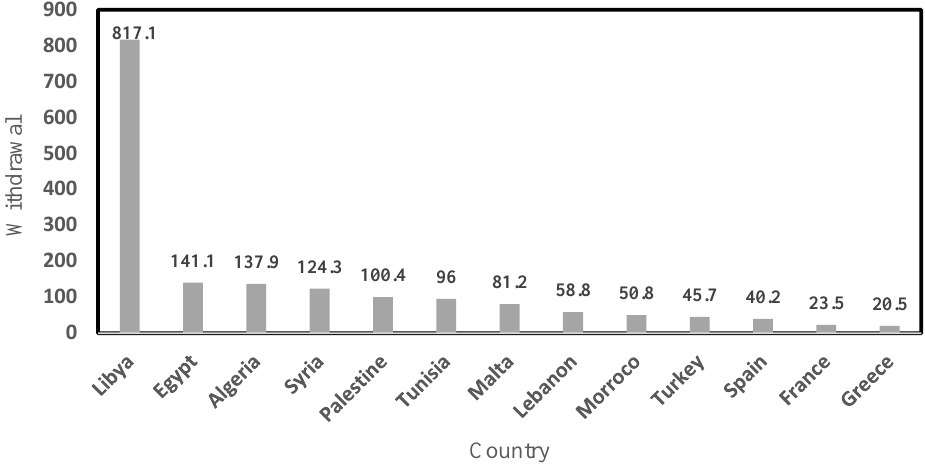
Figure 2. Freshwater withdrawal as a proportion of available freshwater resources in 2019. Source of data: Food and Agriculture Organization (FAO).